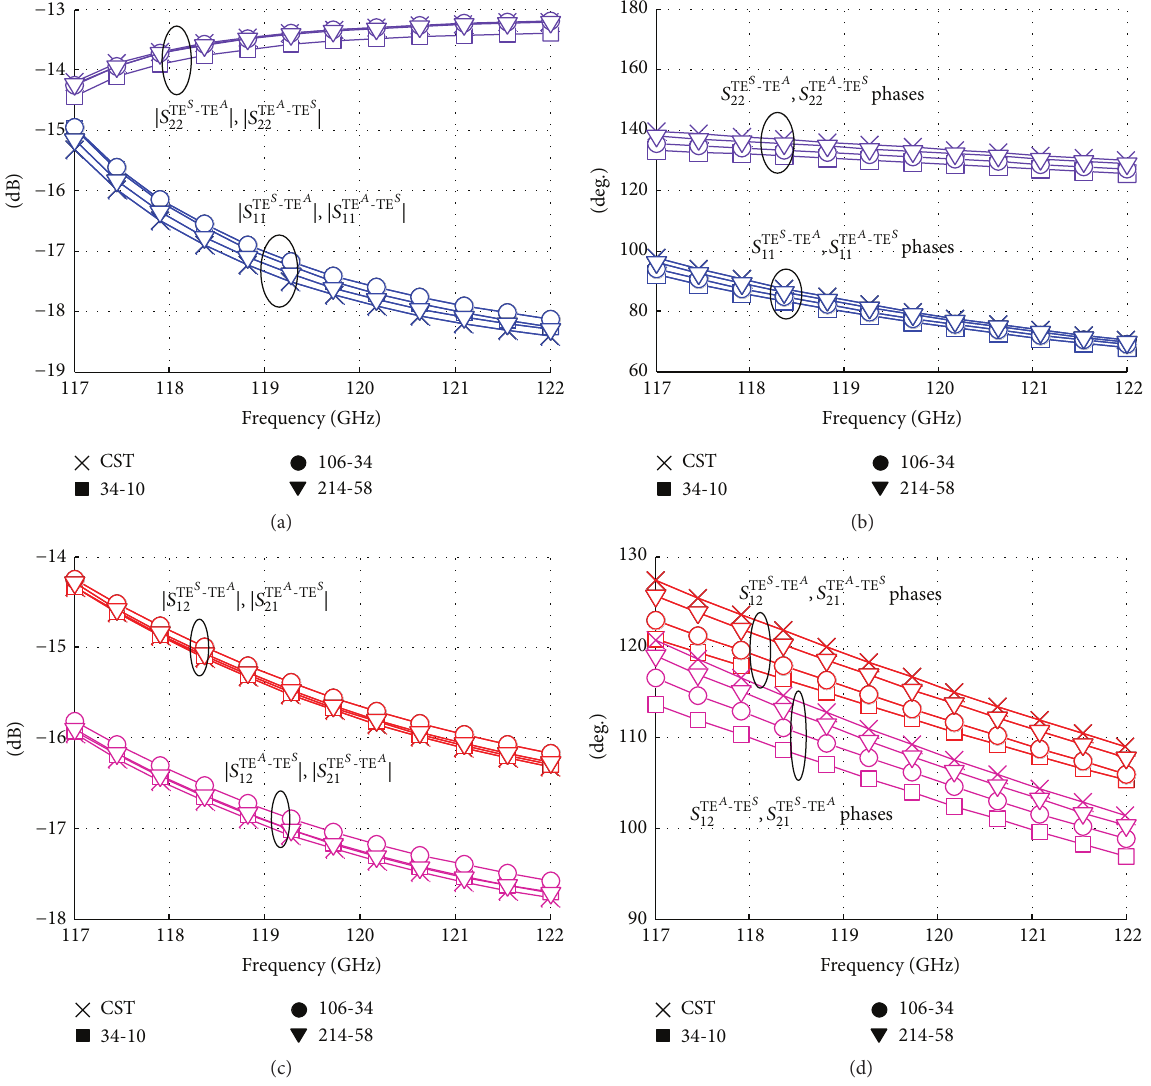
Figure 11: Case study b: mode TE 𝐴 10 in waveguide 1 to mode TE 𝑆 10 in waveguide 2 and mode TE 𝑆 10 in waveguide 1 to mode TE 𝐴 10 in waveguide 2 : (a) reflection magnitude, (b) reflection phase, (c) transmission magnitude, and (d) transmission